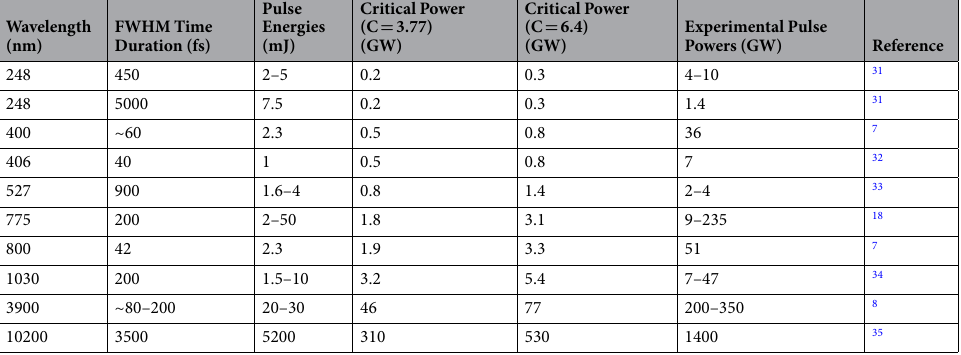
Table 1. Filaments in air observed in literature. Critical powers are estimated with Eq. (2) using n 2 ~ 5 × 10 − 19 cm 2 /W as an estimate from literature 7 , and experimental pulse powers are computed with Eq. (1) assuming a Gaussian